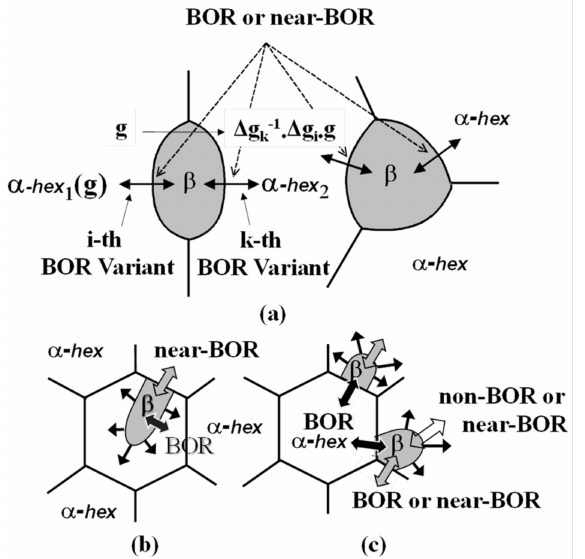
Figure 1. Schematic representations of ( a ) nucleation of DBOR variants and ( b ) growth by coherent interfaces and ( c ) semi-coherent or incoherent interfaces of selected variants by DBOR in α -hex → β transformation. EDBOR growth can occur by mobile semi-coherent and incoherent interfaces.